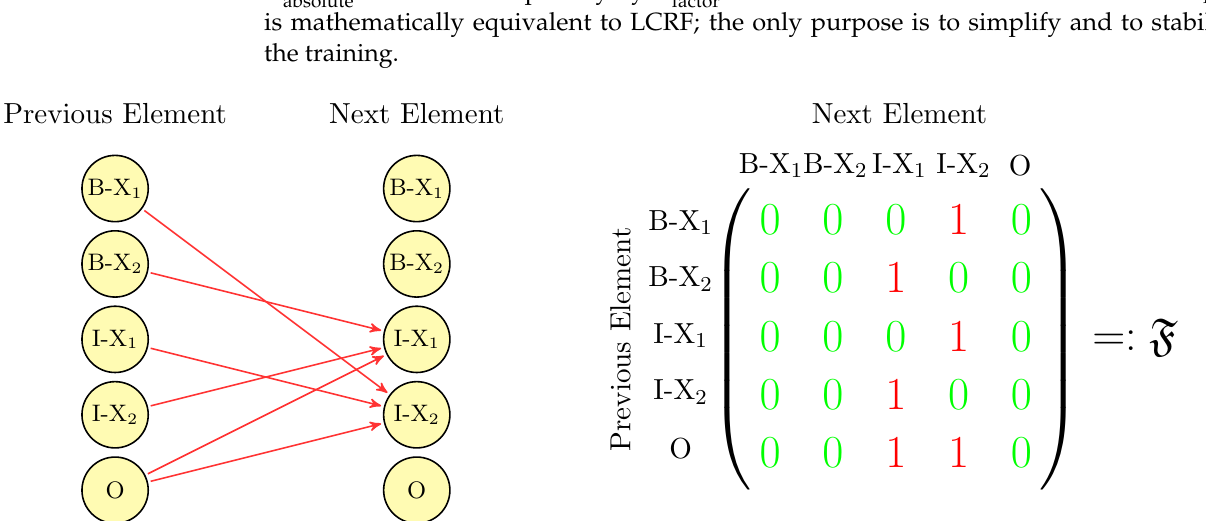
Figure 1. Example for the definition of the matrix F of all forbidden transitions for two entities X 1 , X 2 . If we follow the IOB tagging scheme, red arrows mark forbidden transitions between two sequence elements that lead to an entry 1 in F .